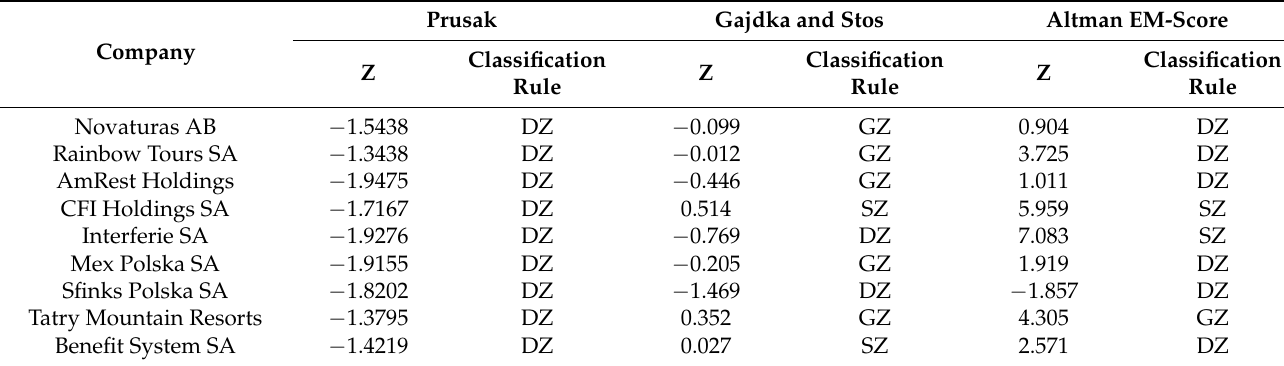
Table 2. The value of the discriminant functions in the first half of 2020.